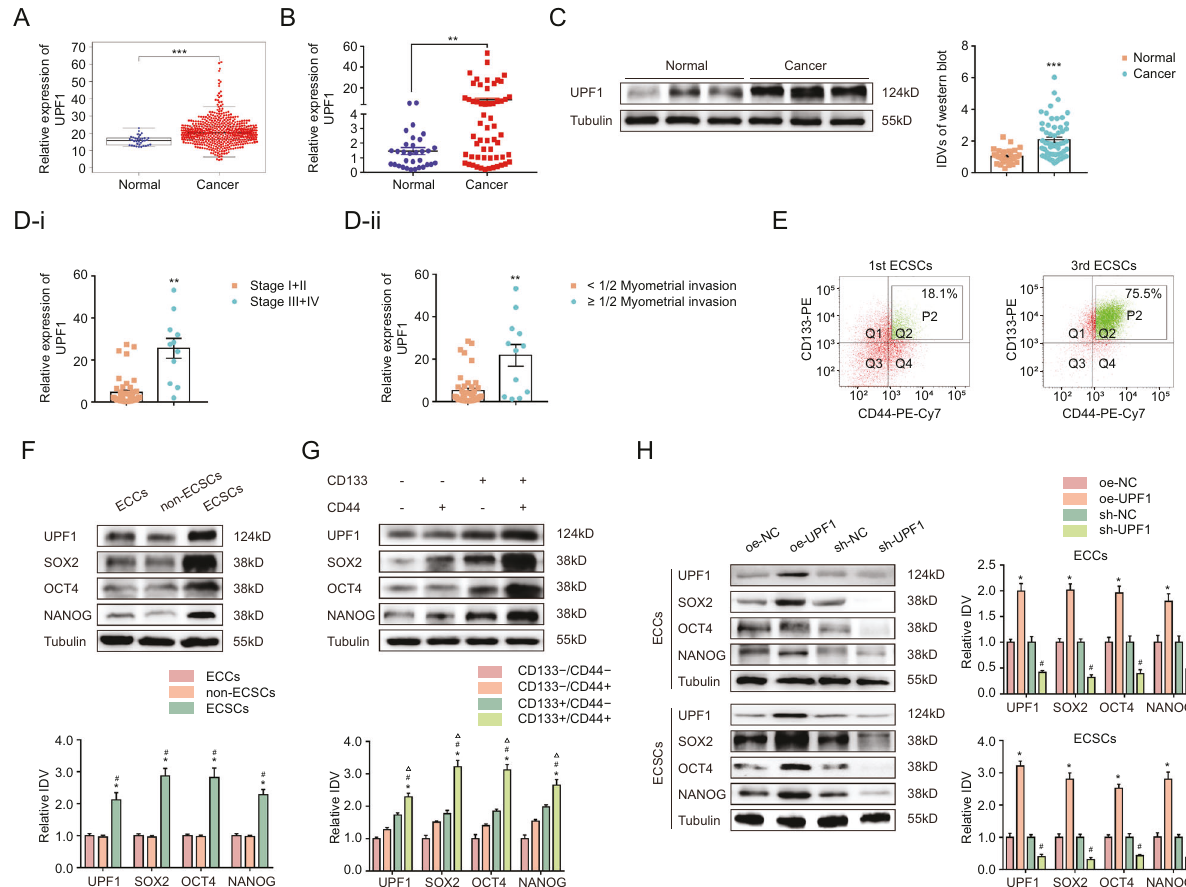
Fig. 1 UPF1 is upregulated in EC tissues and functioned as a signature gene of ECSCs. A UPF1 expression levels in EC tissues ( N = 546) and normal tissues ( n = 33) in the TCGA cohort. B UPF1 expression levels in EC tissues ( n = 58) compared to normal tissues ( n = 32) detected using qRT-PCR. Data are presented as the means ± SEM, ** P < 0.01. C UPF1 expression levels in EC tissues ( n = 58) compared to normal tissues ( n = 32) detected using western blotting. Data are presented as the means ± SEM, *** P < 0.001. D UPF1 expression levels in patients with different ( D -i) tumor stages and ( D -ii) myometrial invasion in EC tissues ( n = 58) compared to normal tissues ( n = 32). Data are presented as the means ± SEM, ** P < 0.01. E Flow cytometry analysis of CD133 + /CD44 + cells sorted from the 1st and 3rd ECSCs. F The expression of UPF1, SOX2, OCT4, and NANOG in ECCs, non-ECSCs, and ECSCs detected using western blotting. The results are presented as the ratio of the integrated density values of UPF1, SOX2, OCT4, and NANOG versus Tubulin. The graphs represent the alteration in relation to ECCs (protein of interest/ Tubulin equal to 1). Data are presented as the means ± SEM ( n = 3, each group), * P < 0.05 vs. ECCs group, # P < 0.05 vs. non-ECSCs group. G The expression of UPF1, SOX2, OCT4, and NANOG in CD133 − /CD44 − , CD133 − /CD44 + , CD133 + /CD44 − , and CD133 + /CD44 + cells detected using western blotting. The results are presented as the ratio of the integrated density values of UPF1, SOX2, OCT4, and NANOG versus Tubulin and the graphs represent the alteration in relation to the CD44 − /CD133 − cells (protein of interest/Tubulin equal to 1). Data are presented as the means ± SEM ( n = 3, each group), * P < 0.05 vs. CD133 − /CD44 − group, # P < 0.05 vs. CD133 − /CD44 + group, △ P < 0.05 vs. CD133 + / CD44 − group. H Effect of UPF1 overexpression or knockdown on SOX2, OCT4, and NANOG expression assessed using western blotting. The results are presented as the ratio of the integrated density values of UPF1, SOX2, OCT4, and NANOG versus Tubulin. The graphs represent the alteration in the oe-UPF1 group and the sh-UPF1 group relative to their respective control groups (protein of interest/Tubulin equal to 1). Data are presented as the means ± SEM, * P < 0.05 vs. oe-NC group, # P < 0.05 vs. sh-NC